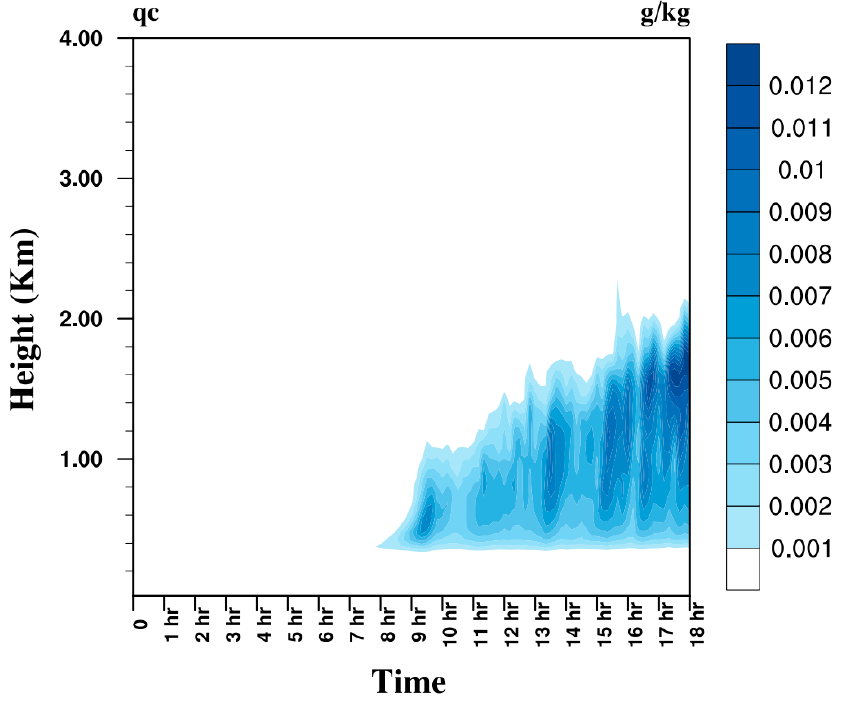
Figure 3. Contour plot of horizontally averaged cloud liquid water content.